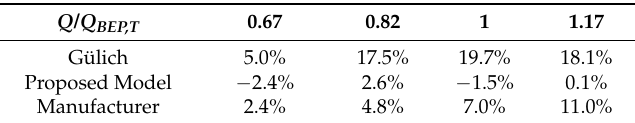
Table 4. Comparison of different prediction models for PaT characteristic curve in terms of head prediction